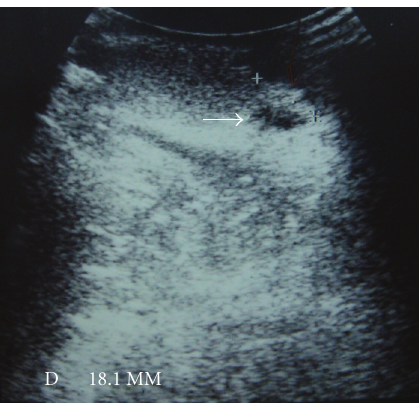
Figure 1: Scrotal ultrasound showing a focal cystic paratesticular mass with compressed testicular parenchyma (arrowhead).